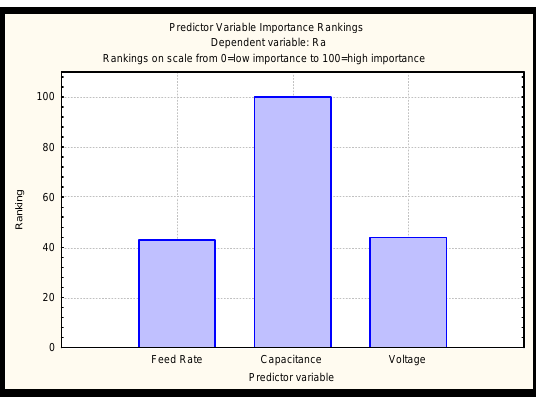
Fig. 3. Predictor variable importance ranking for Ra Classification Tree for